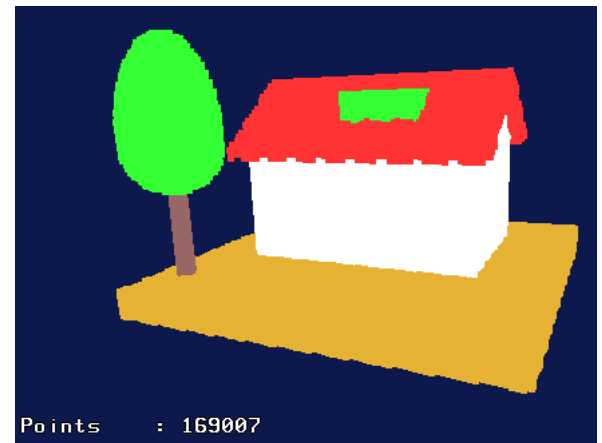
Fig. 10: 3D sparse boundary grid with different xor values after voxelization stage 1 (left) and full voxel grid after top-to-bottom xor prefix in stage 2 (right)